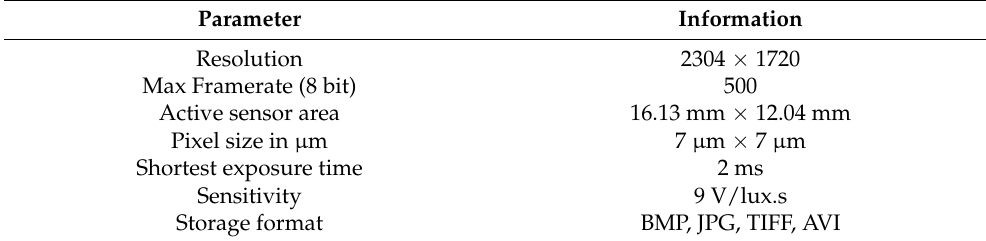
Table 2. CP80-4-M-500